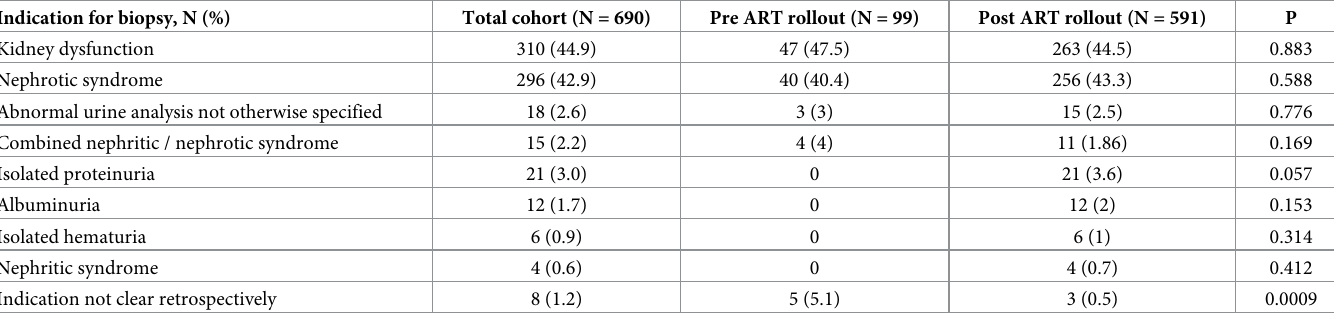
Table 2. Indications for biopsy in HIV-positive patients who underwent kidney biopsy. Indication for biopsy, N